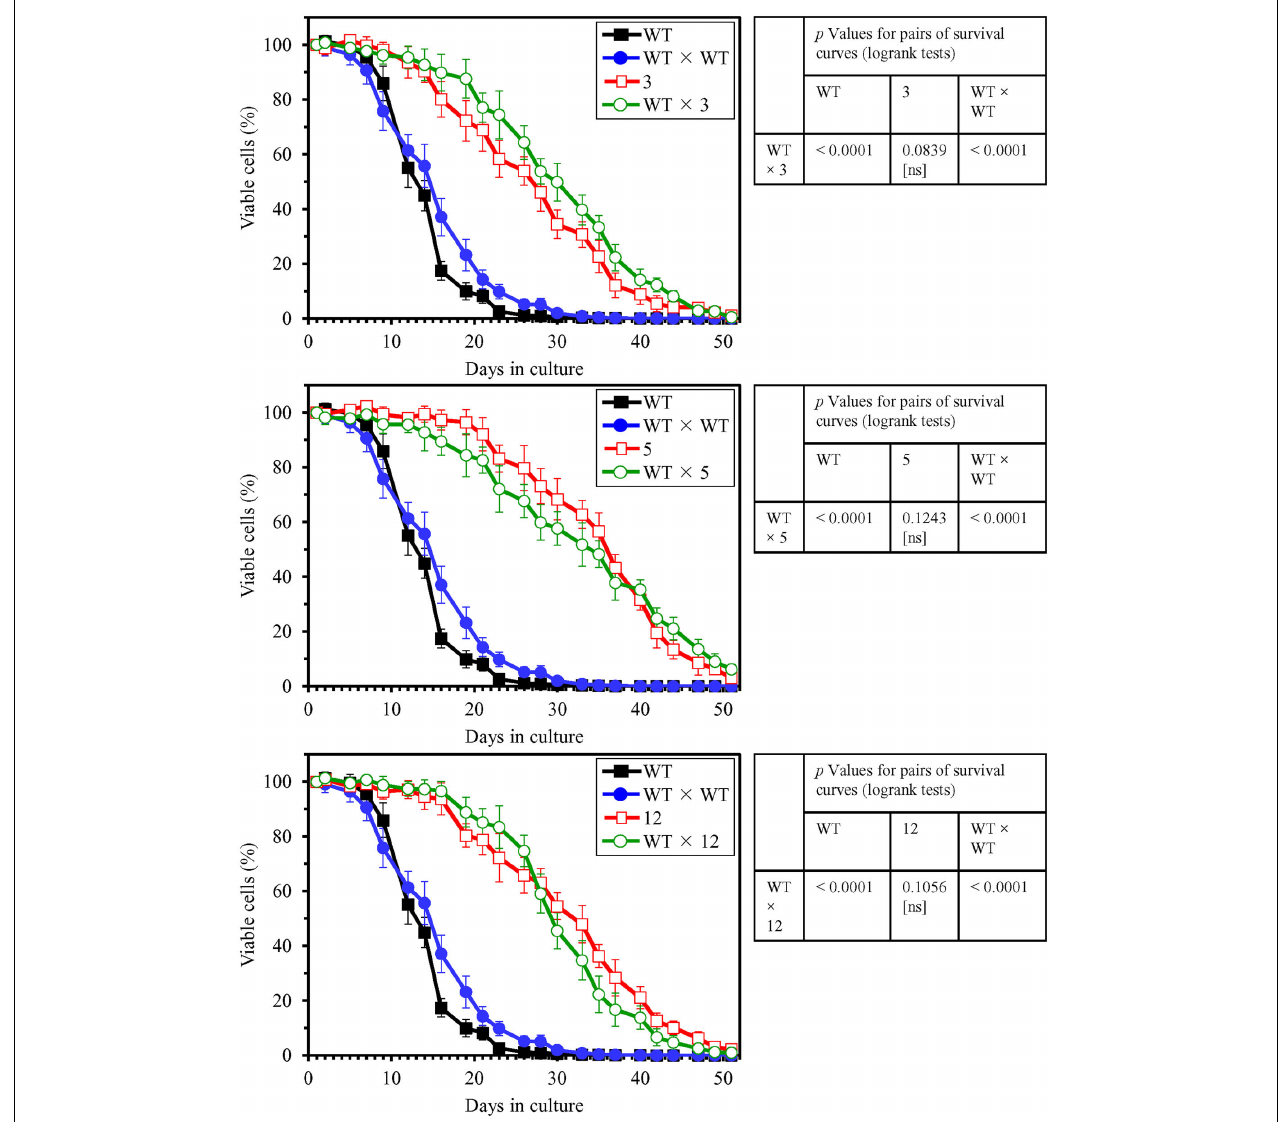
FIGURE 5 | The extended longevity of each of the three long-lived yeast mutants evolved under laboratory conditions is a dominant genetic trait. The parental haploid WT strain BY4742, the WT × WT diploid strain formed by mating between the haploid WT strains BY4741 and BY4742, the long-lived mutant strains 3, 5, and 12 (each in the BY4742 genetic background), and the WT × 3, WT × 5, and WT × 12 diploid strains were cultured in YP medium without LCA initially containing 0.2% glucose. Survival curves of chronologically aging cells are shown. Data are presented as means ± SEM ( n = 4). The p values for comparing pairs of survival curves using the log-rank test were calculated as described in Section “Materials and Methods.” The survival curve for the WT × 3, WT × 5, or WT × 12 diploid strain was considered statistically different from the survival curve for the parental haploid mutant strain, parental haploid WT strain, or WT × WT diploid strain if the p value was less than 0.05. ns , not